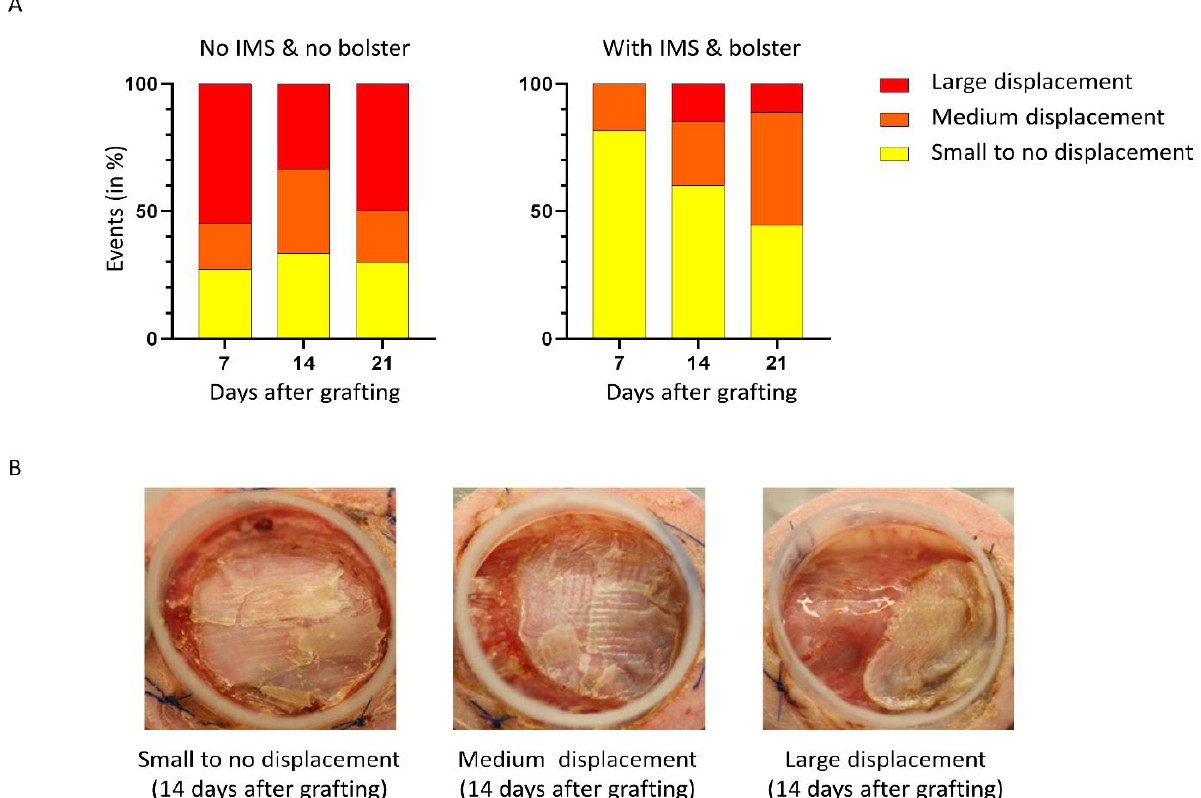
Figure 2. Qualitative assessment of displacement events following surgery. ( A ) Displacement of the graft was assessed over time after grafting. For each mouse, the displacement was evaluated (large, medium, or small to no displacement). Results are presented as the percentage of mice in each category 7, 14, and 21 days after grafting. ( B ) Representative examples of SASS displacement 14 days after grafting on the back of athymic mice.